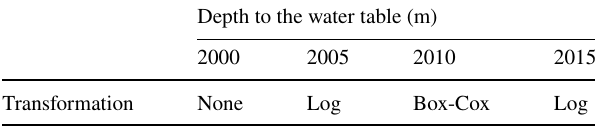
Table 1 Types of data transformation Depth to the water table